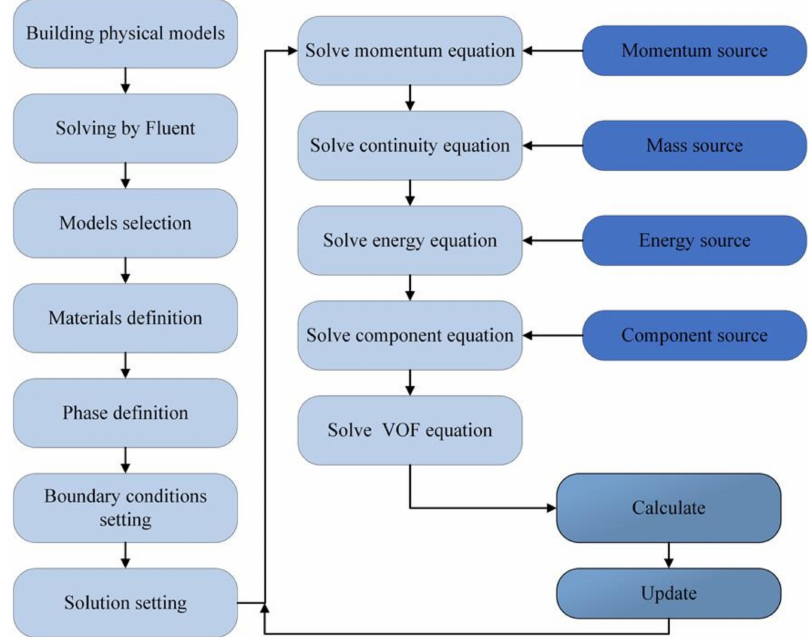
Figure 3. Simulation flow